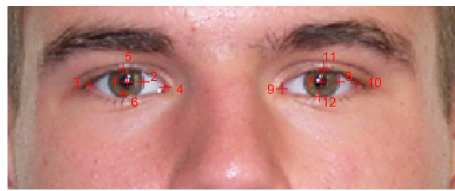
Figure A1. The 12 annotation points used to define the eye features. Table A1. The 12 landmarks defining the eye features.